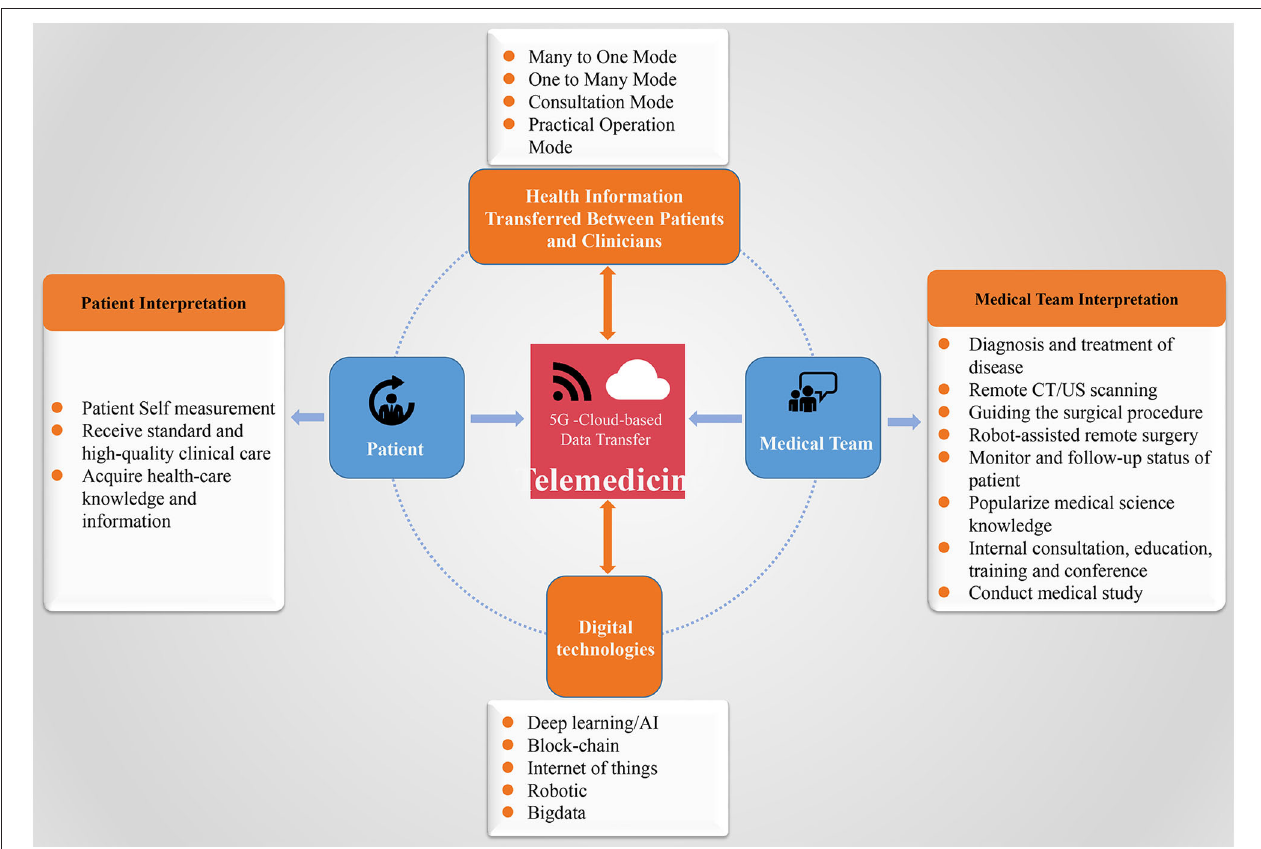
FIGURE 7 | The proposed data flow of telemedicine for clinical care: to maximize clinical care though telemedicine system, a closed loop is quite necessary, which involves healthcare data derived from patients and practitioners; transferred via 5G-Cloud internet; interpreted by the patients, medical practitioners, or with certain automated platforms (e.g., AI, robot, and big data analysis); and returned back to the patients and medical staff for better clinical decisions. And in turn, the large-scale shared cloud-based data would provide a great opportunity for AI development. 5G, fifth generation; AI, artificial intelligence; CT, computed tomography; US,